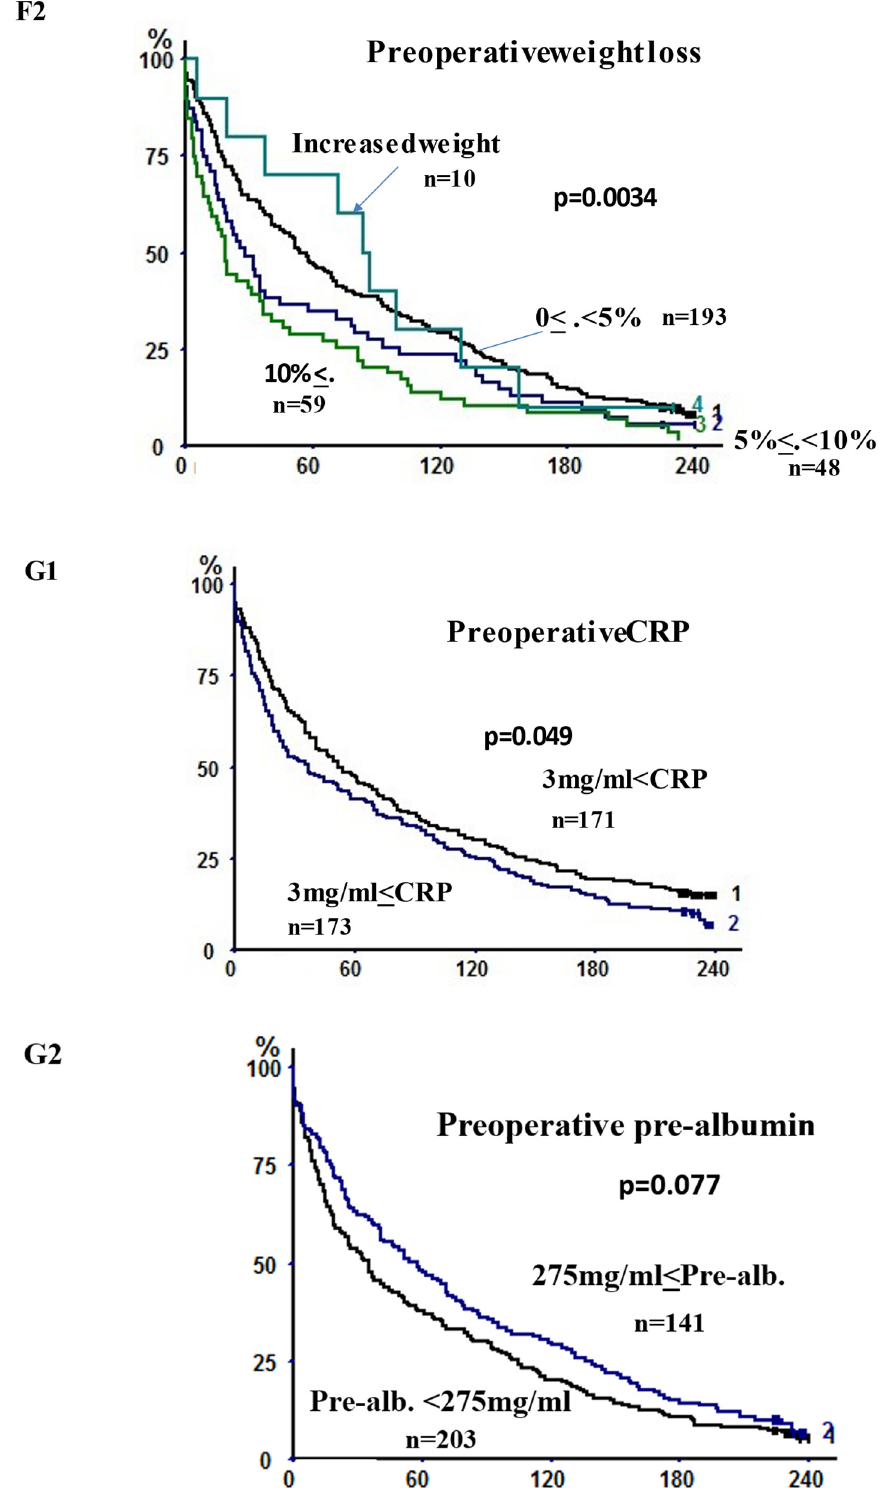
Figure 2. Kaplan–Meier survival analyses and log-rank comparisons for the patient of the study for different variables: sex (panel A1 ), age at implantation (panel A2 ), pathological stages (4 classes) (panel B1 ), tumor characteristics (type of tumor (panel C1 ) and grade of adenocarcinoma (panel C2 )), type of resection (panel D ), chronic bronchitis (panel E1 ), morphomics and nutritional parameters (BMI (panel F1 ) and preoperative weight loss (panel F2 )), biological preoperative parameters (CRP (panel G1 ) and preoperative prealbumin (panel G2 )). See also Supplemental Figure S1 in